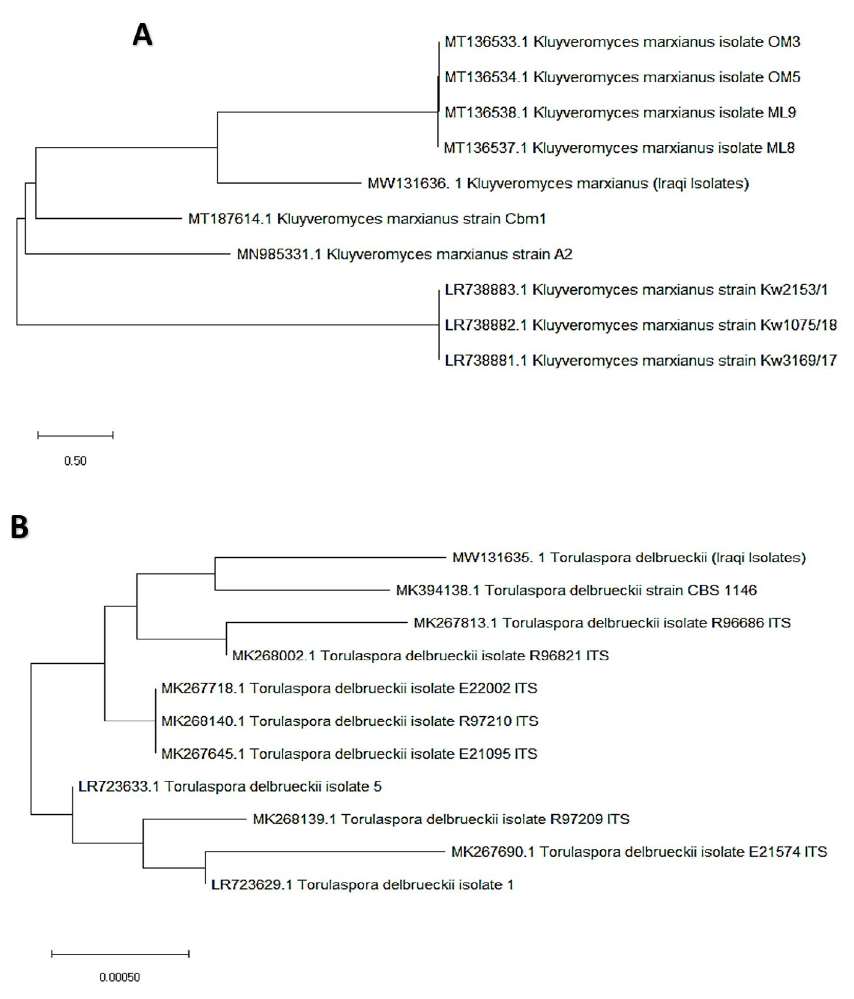
Fig. 1. Phylogenetic tree showing the position of A- K. marxianus among related species of K. marxianus B- T. delbrueckii among related species of T. delbrueckii from NCBI, as represented by the bootstrap consensus tree inferred with the neighbor-joining method from 1000 replicates derived from the analysis of 26S rDNA by sequencing the region ITS1-ITS4. The trees are drawn in scale, with branch length in the same units as those of evolutionary distance used to infer the phylogenetic tree using MEGA